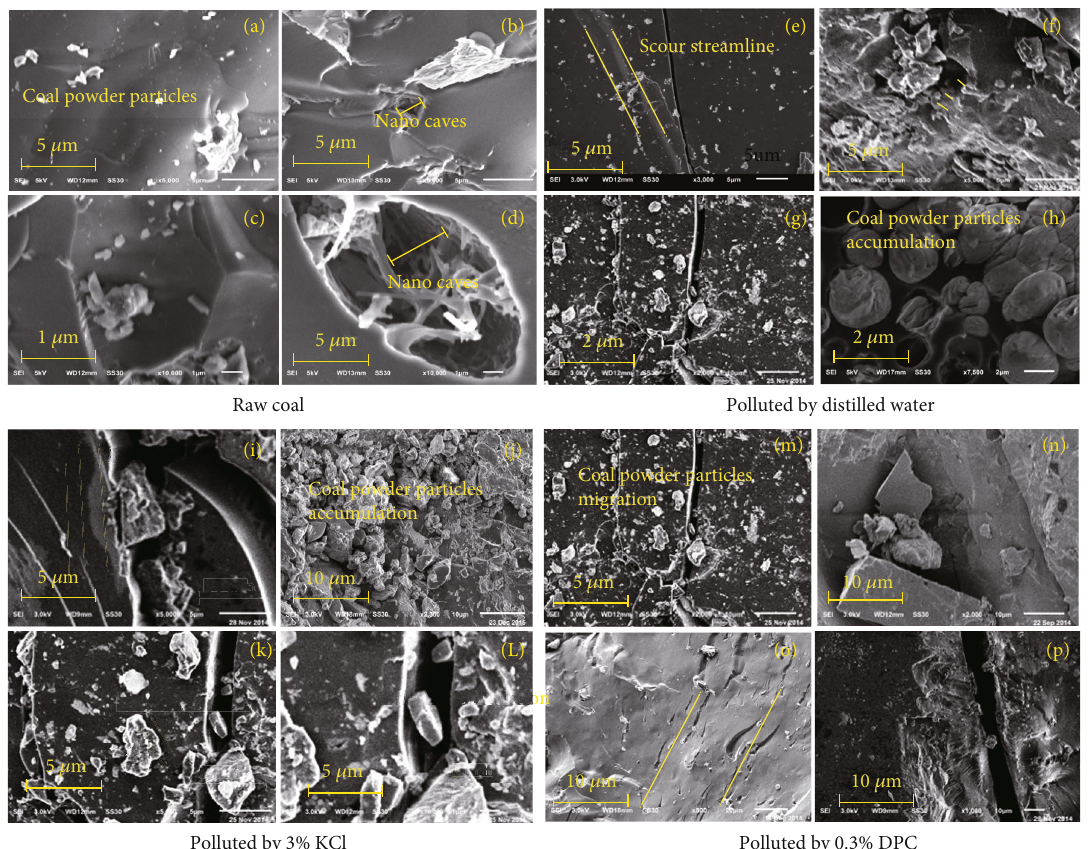
Figure 8: Micromorphology of raw coal core and polluted coal